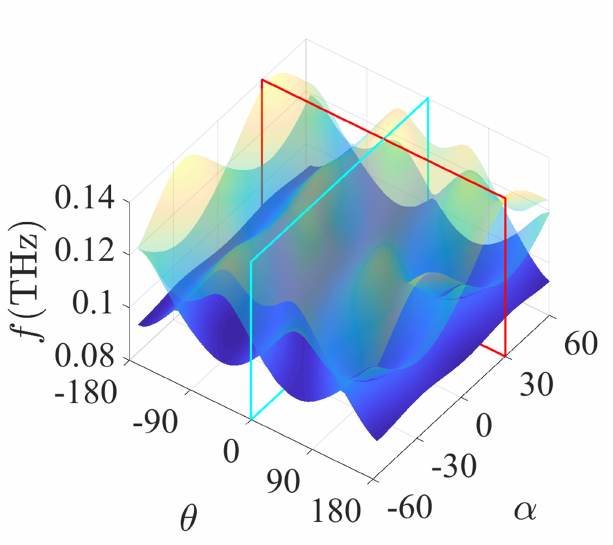
Figure A1. Dependence of topological phase transition at K point on global α and individual θ rotations. Specifically, the cross sections formed by the cyan frame and the red frame are shown in Figure